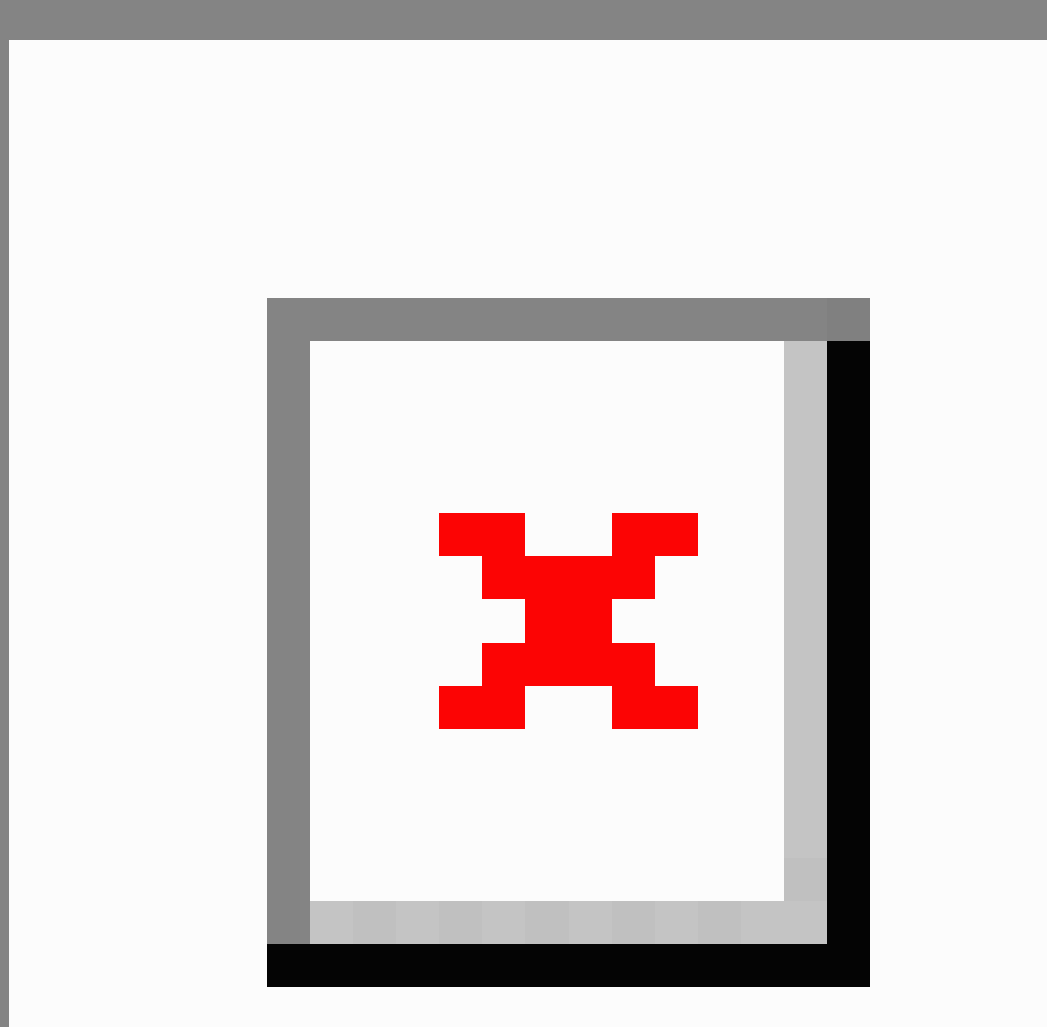
Figure 5. Results of syndromic surveillance conducted in Internet Panel Survey I. Circles: alerts reported by early aberration reporting system (EARS). Diamonds: alert occurrence dates coincident with the regional outpatient symptomatic surveillance in medical